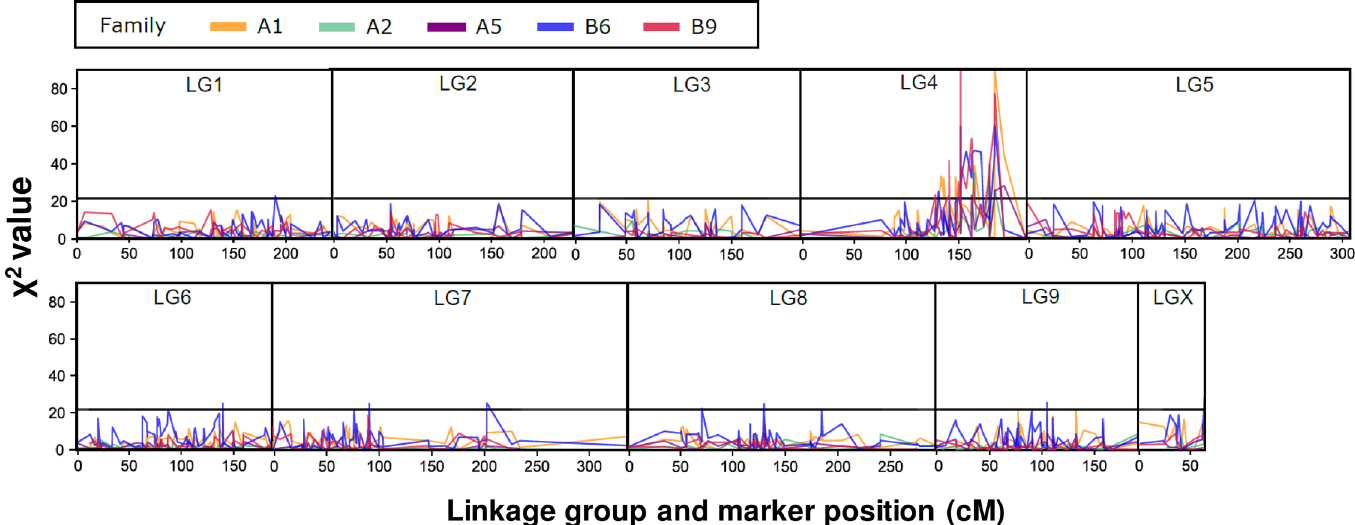
Fig 5. DvSnf7 dsRNA resistant locus is located on LG 4. Reciprocal single parent crosses were made between WCR-R and WCR-S beetles. Families A1, A2, and A5 contained a male WCR-R parent whereas families B6 and B9 contained a female WCR-R parent. F 2 individuals surviving on DvSnf7 or NT maize from each of five families were genotyped using the WCR SNP genotyping platform. Each panel represents one of the ten WCR linkage groups (LG). Within each LG, markers are ordered based on their genetic map position. The y-axis gives the χ 2 test statistic between the genotypic counts among F 2 populations surviving maize expressing DvSnf7 dsRNA or a non-transgenic control. Results from each of the five mapping families are plotted using a separate color following the legend above the figure. A black horizontal line on each panel indicates the Bonferroni threshold of 21.8.